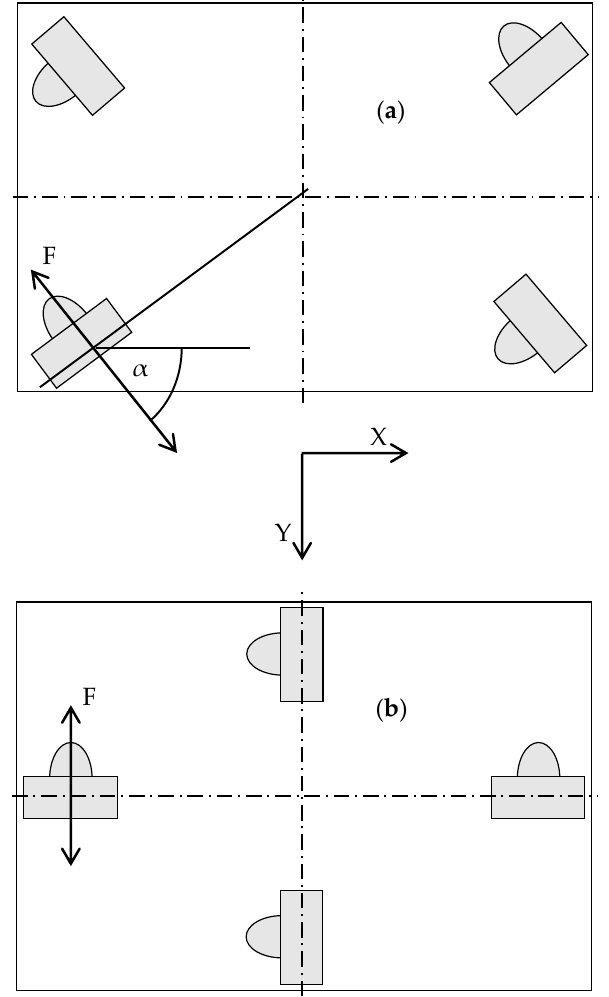
Figure 4. Comparison of horizontal thruster configuration. ( a ) Vectored horizontal thruster configuration; ( b ) Non-vectored thruster configuration.